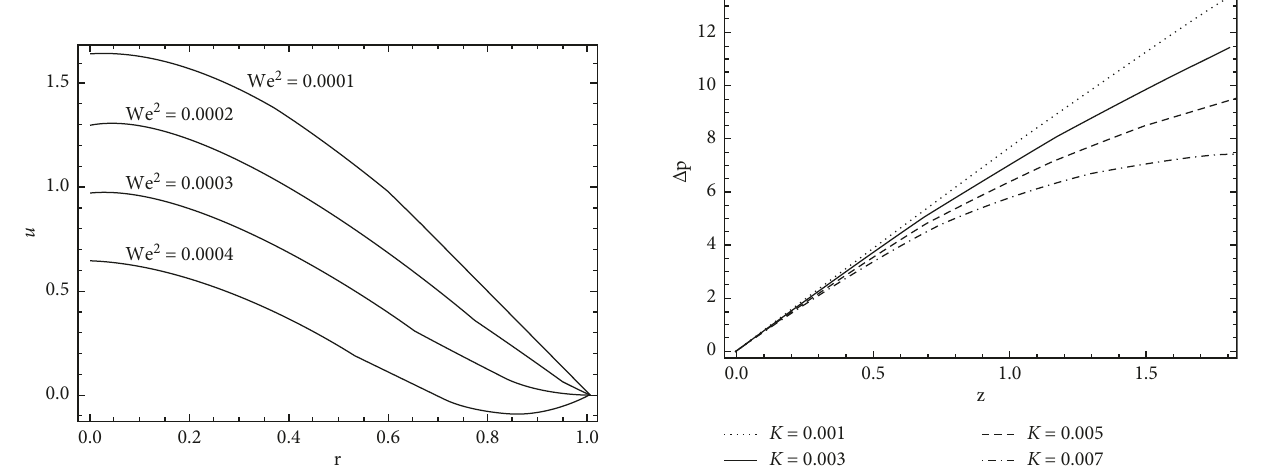
Figure 4: Variation of axial velocity u with r for different values of We 2 , where z � 0.1, P 0 � 43, K � 0.001, n �− 1, and m � 0.5.